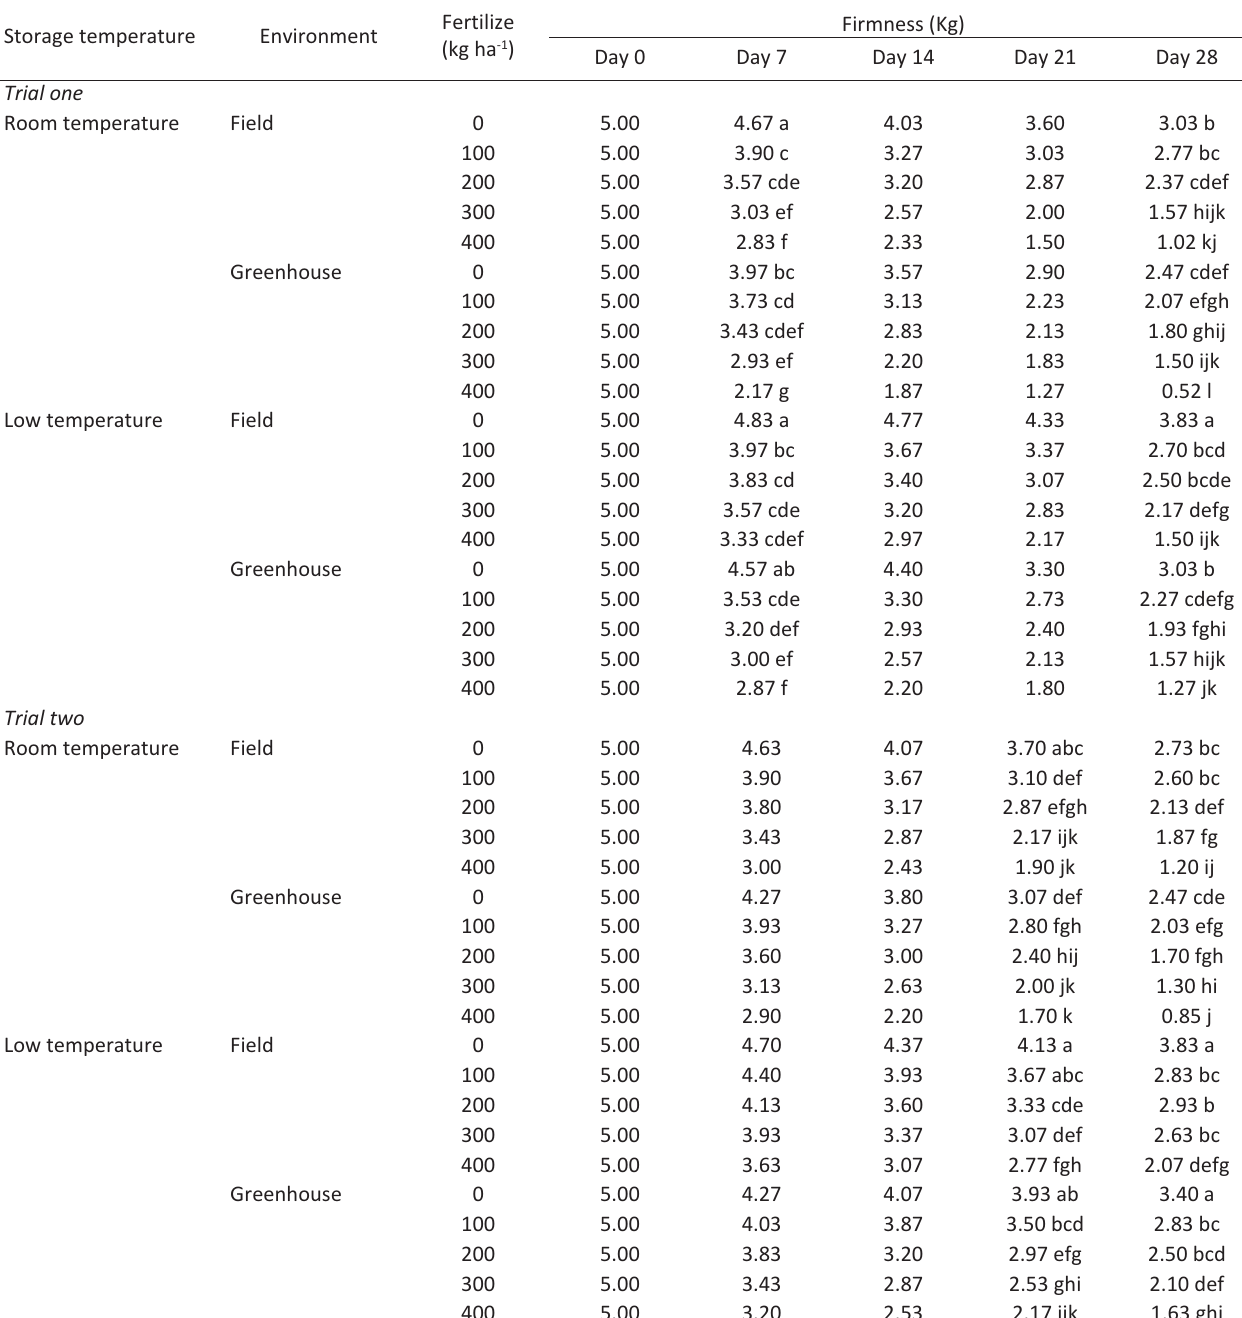
Table 4 ­ Effect of NPK fertilizer rates, growing environment and storage temperature on firmness (kg) of pepino melon fruits in trial one and